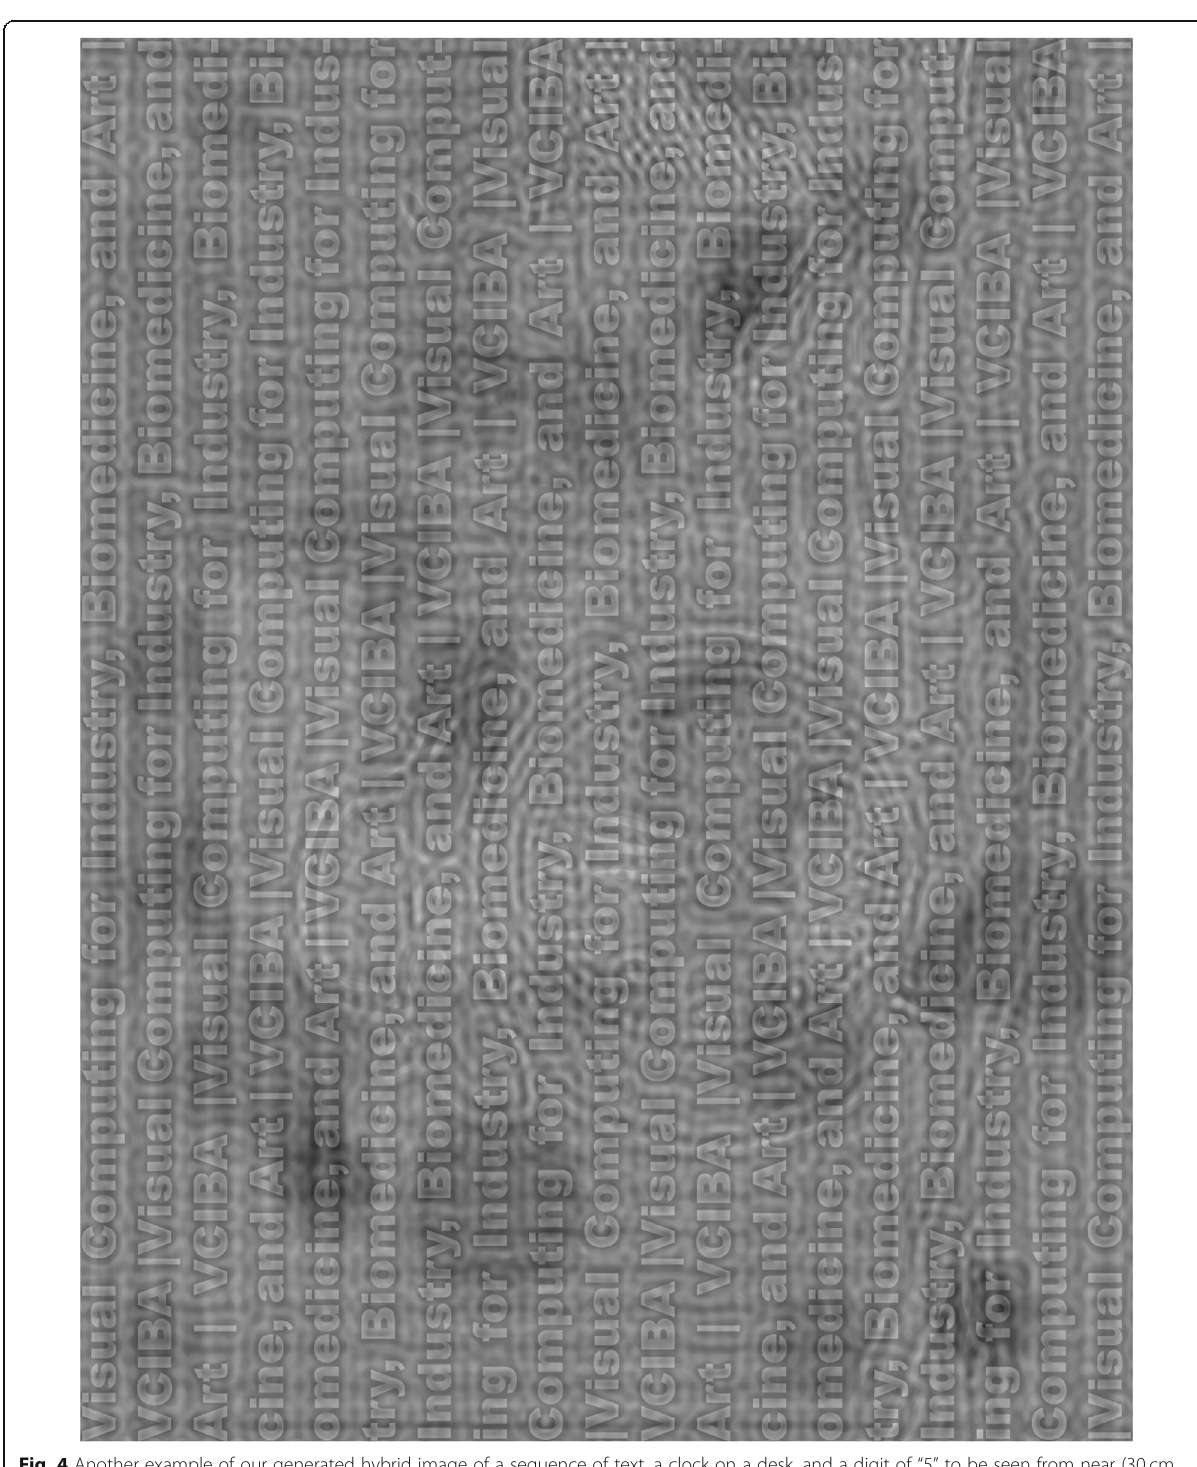
Fig. 4 Another example of our generated hybrid image of a sequence of text, a clock on a desk, and a digit of “ 5 ” to be seen from near (30 cm or 26.56° of visual angle), middle (200 cm or 4.29° of visual angle), and far distance (500 cm or 1.72° of visual angle), respectively. This figure is rotated by 90 degrees to occupy as much space as possible. Source image for a clock on a desk: “ Black Twin Bell Alarm Desk Clock on Table ” ,© 2017 by JESHOOTS.COM, used under CC0 from https://www.pexels.com. Other source images were synthesized by this manuscript